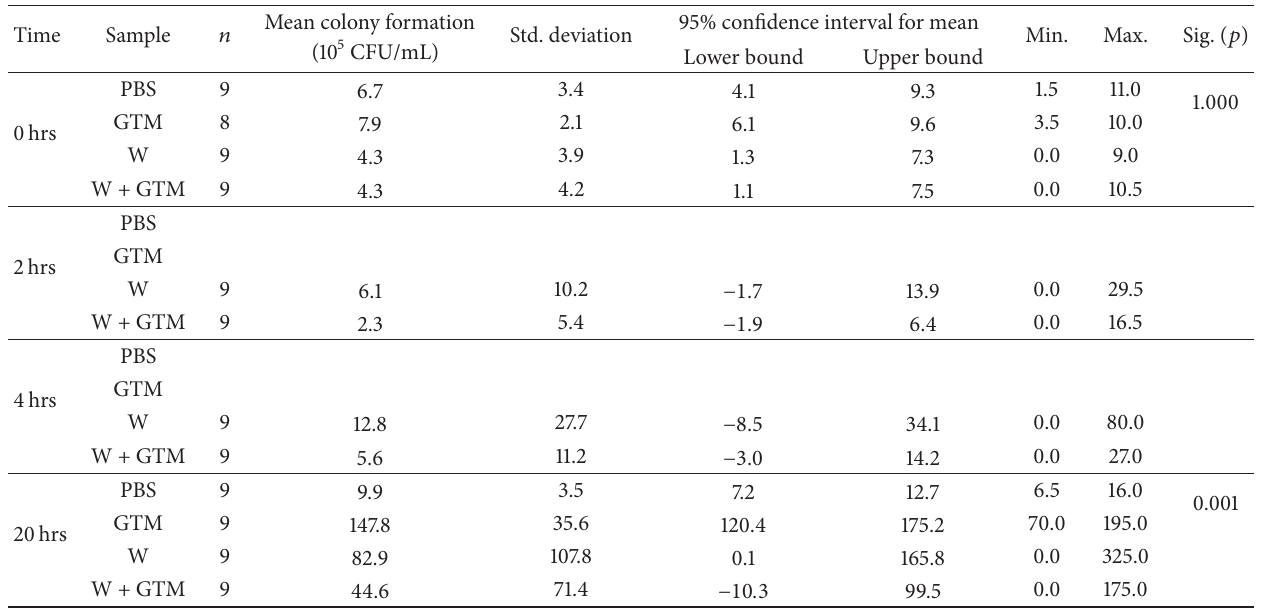
Table 1: Colony formation of E. coli in PBS or pelvic washings ± GTM.